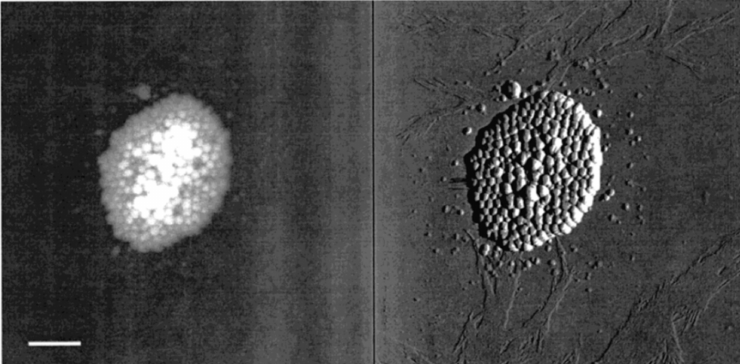
Figure 5. AFM height (left) and deflection (right) images of a typical Sepia o ffi cinalis eumelanin aggregate (the scale bar is 970 nm) (Reprinted (adapted) with permission from Ref. [67]). Copyright 2001 American Chemical